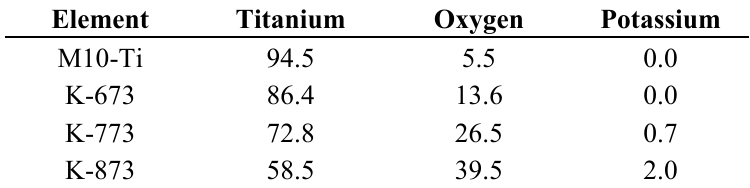
Figure 55. XRD patterns of the samples. Table 4. Composition of the specimens by molten salt